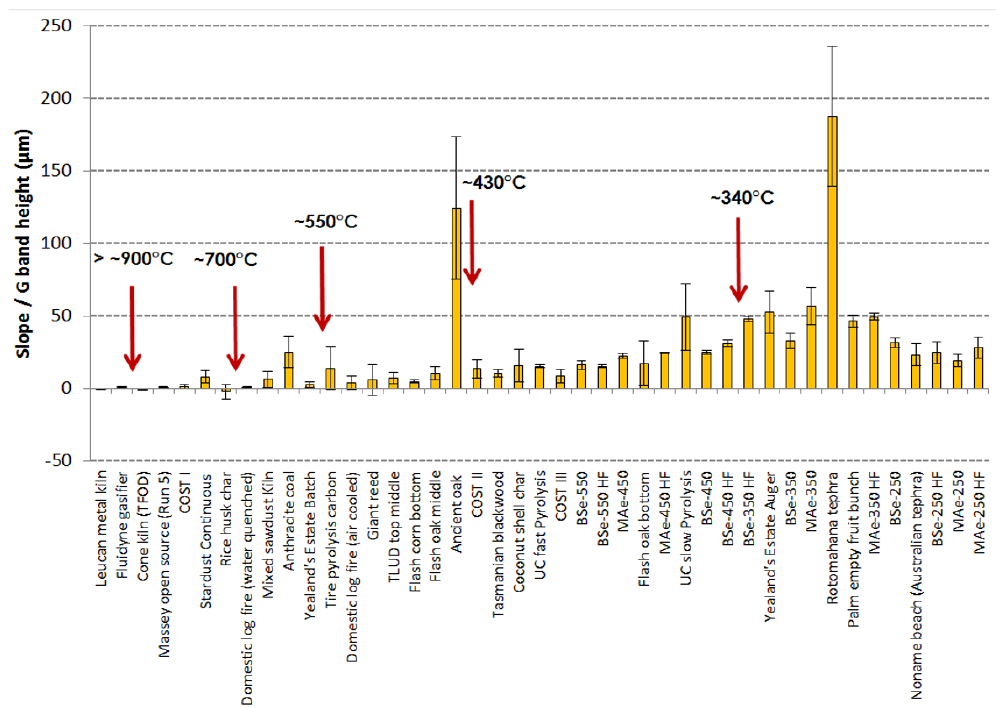
Figure 5. Slope value relative to the G band height. Samples are ranked along X-axis from the highest value of apparent G band position on the left to lowest on the right. Error bars represent 99% confidence intervals. Large positive values for this slope-based parameter indicate hydrogen-rich amorphous carbon. These red arrows are used for approximate signposts for “effective HTT” based on comparisons to a set of laboratory produced